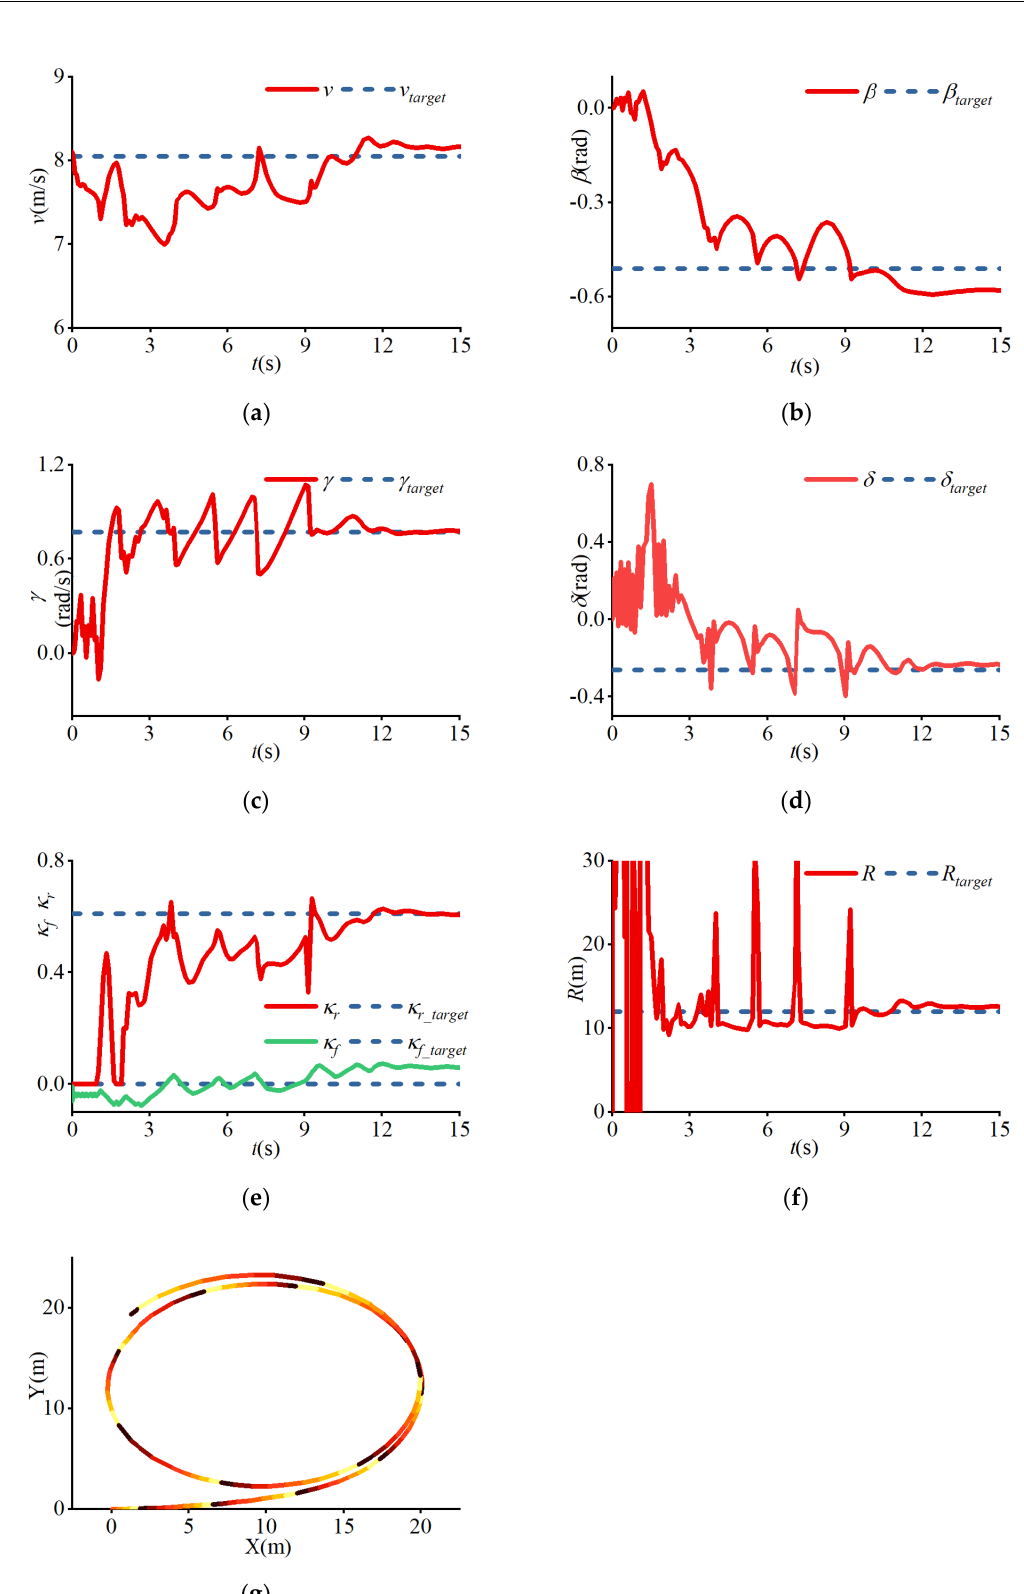
Figure 7. The simulation result with the 10 m/s original velocity and the target group (c): ( a ) the velocity; ( b ) the sideslip angle; ( c ) the yaw rate; ( d ) the steering angle; ( e ) the TYDEX longitudinal slip ratios of the front and rear tires; ( f ) the radius of the motion curve; ( g ) the motion curve of the vehicle. All continuous lines suggest the simulation results, while the dashed lines suggest the targets.